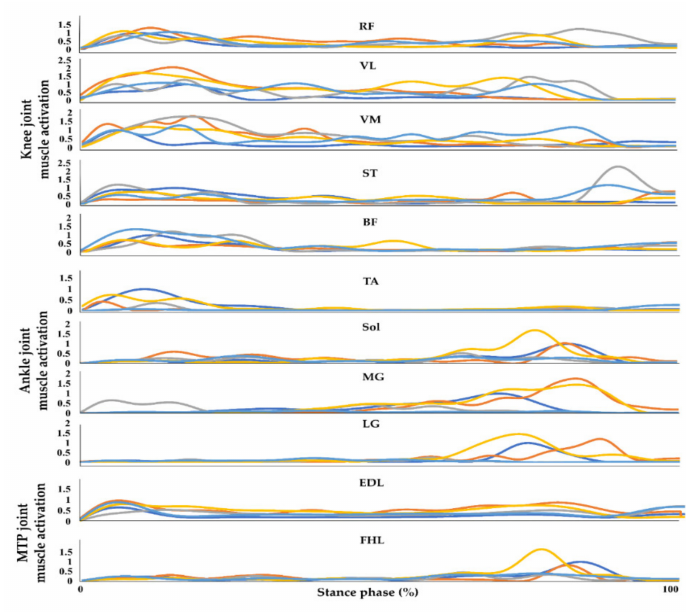
Figure 3. Example of an entire normalized sEMG profile from one trial of a subject collected during the stance phase while walking on flat-ground, upstairs, downstairs, uphill, and downhill. RF, VL, VM, ST, BF, TA, Sol, MG, LG, FHL, and EDL indicate the rectus femoris, vastus lateralis, vastus medialis, semitendinosus, biceps femoris, tibialis anterior, soleus, medial gastrocnemius, lateral gastrocnemius, flexor hallucis longus, and extensor digitorum longus, respectively. The blue, orange, grey, yellow, and sky-blue lines indicate walking on flat-ground, upstairs, downstairs, uphill, and downhill,